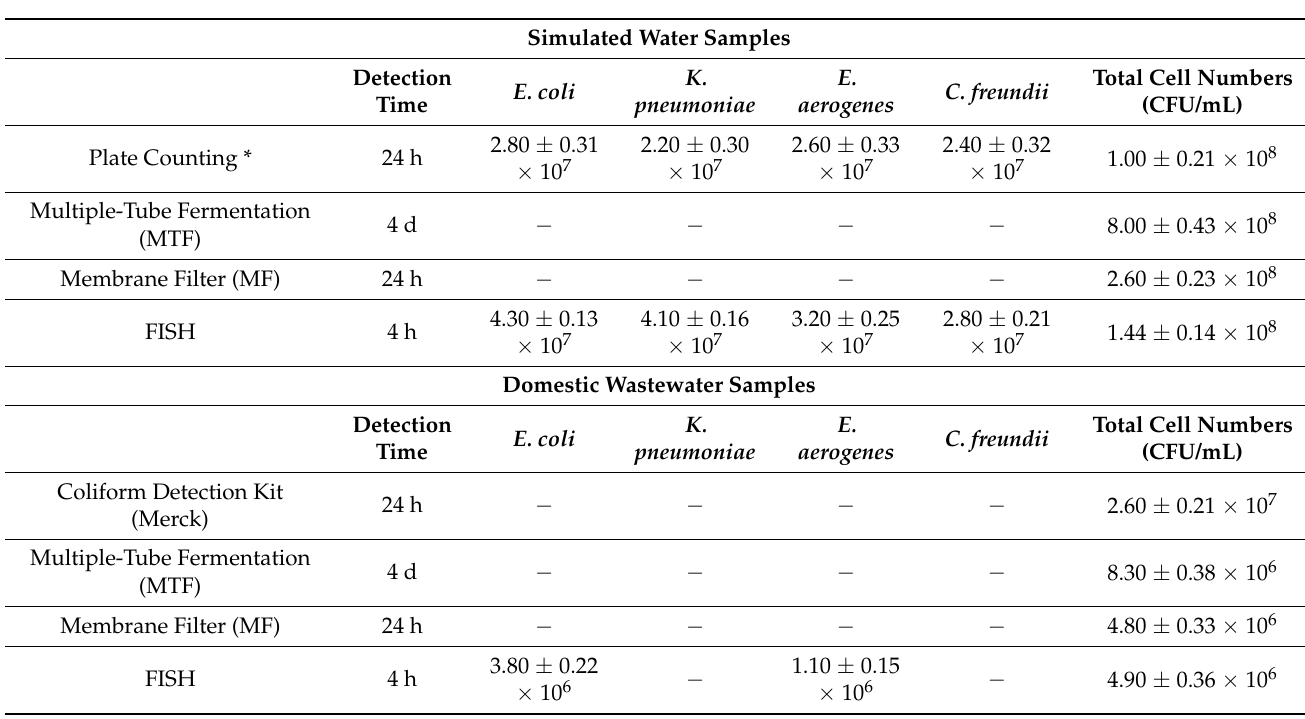
Table 1. Comparison of FISH with other traditional methods for detecting coliform bacteria in simulated water samples or domestic wastewater